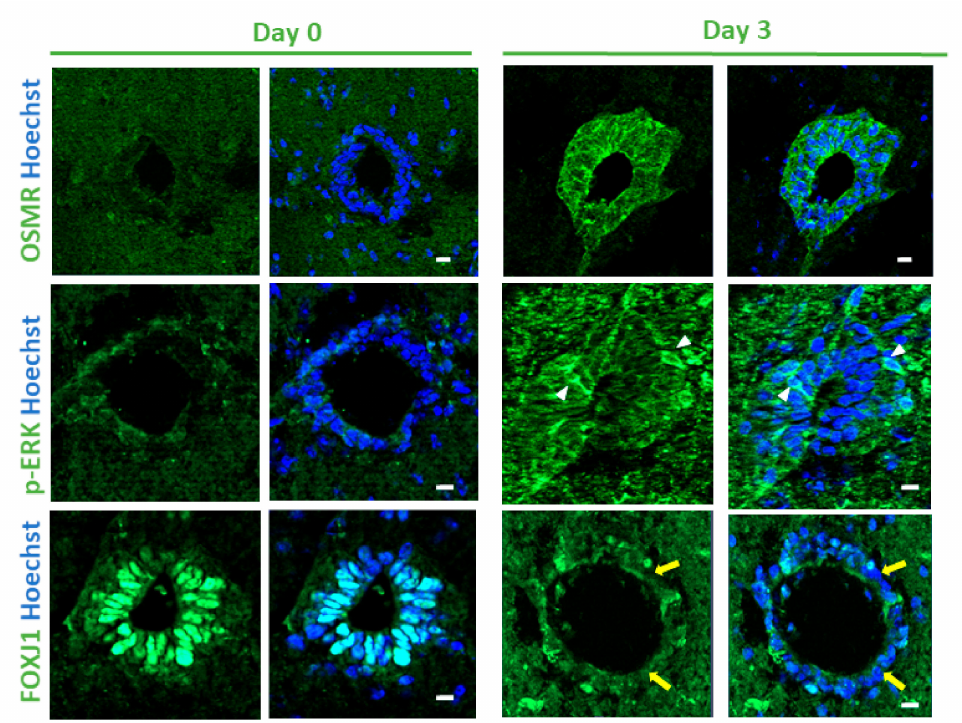
Figure 3. Spinal cord organotypic slice cultures. Immunofluorescences for indicated proteins per- formed on spinal cord slices after collection (Day 0) and after 3 days in culture (Day 3). White arrowheads and yellow arrows show examples of positive and negative cells respectively. These images are representative of 3 independent experiments. ( n = 4 animals, 5 sections examined per culture). Scale bars = 10 µ